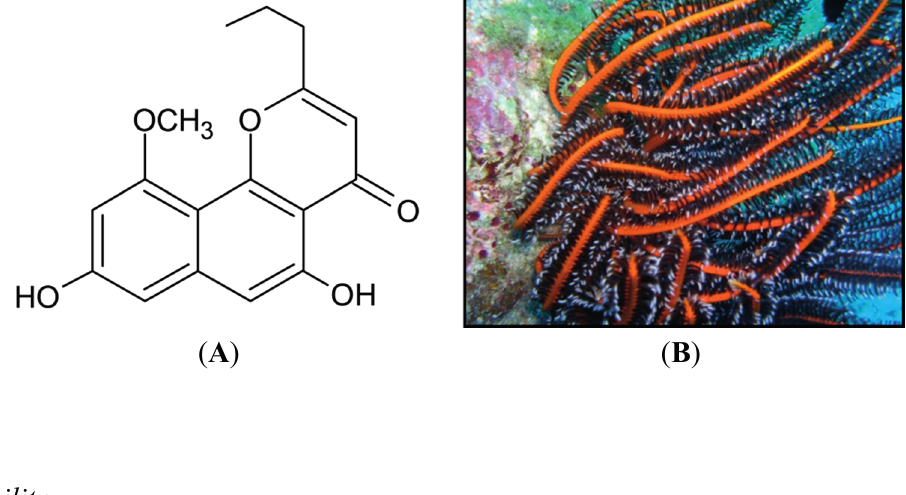
Figure 1. Chemical structure and source of comaparvin. ( A ) Chemical structure of comaparvin. Molecular formula, C 17 H 16 O 5 ; molecular weight, 300.11 Da; ( B ) The crinoid sample, Comanthus bennetti , was collected from Lamay Island,